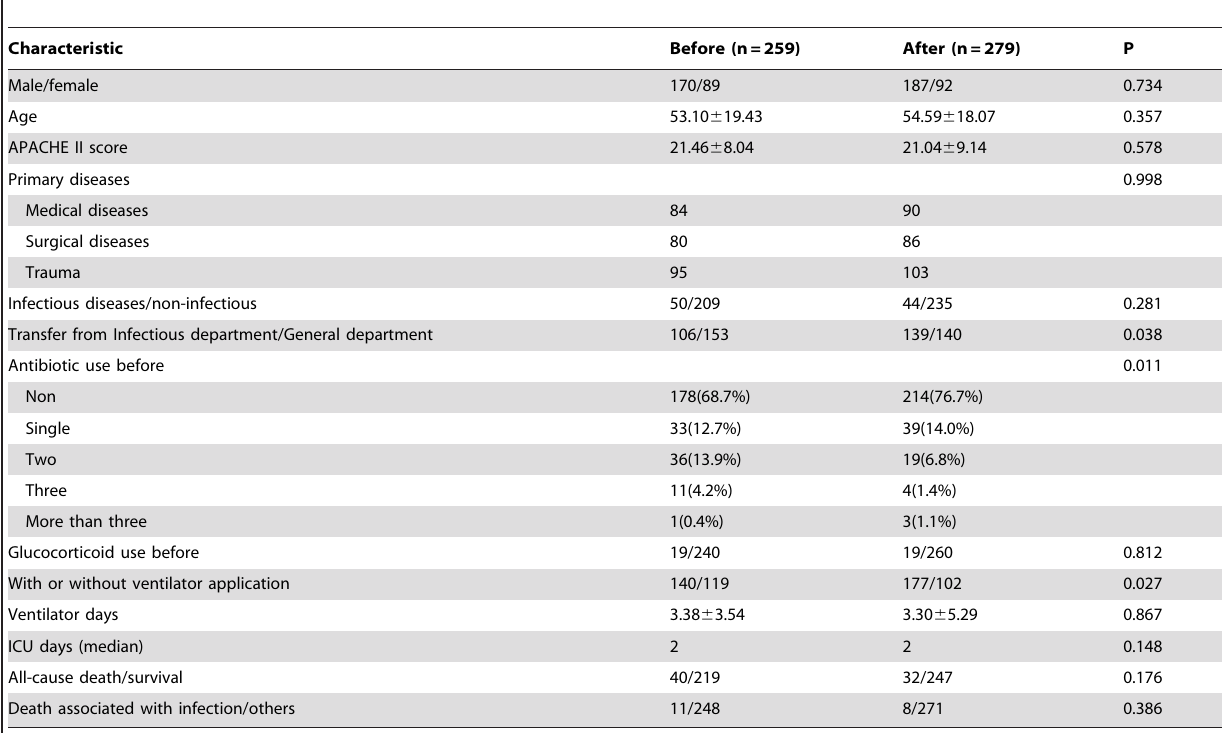
Table 1. Comparison of demographic and clinical data of patients before and after antimicrobial stewardship.